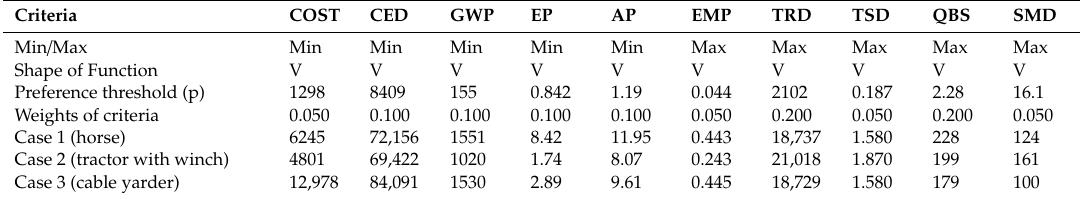
Table 9. Input data (decision matrix) for multi-criteria decision analysis (MCDA).